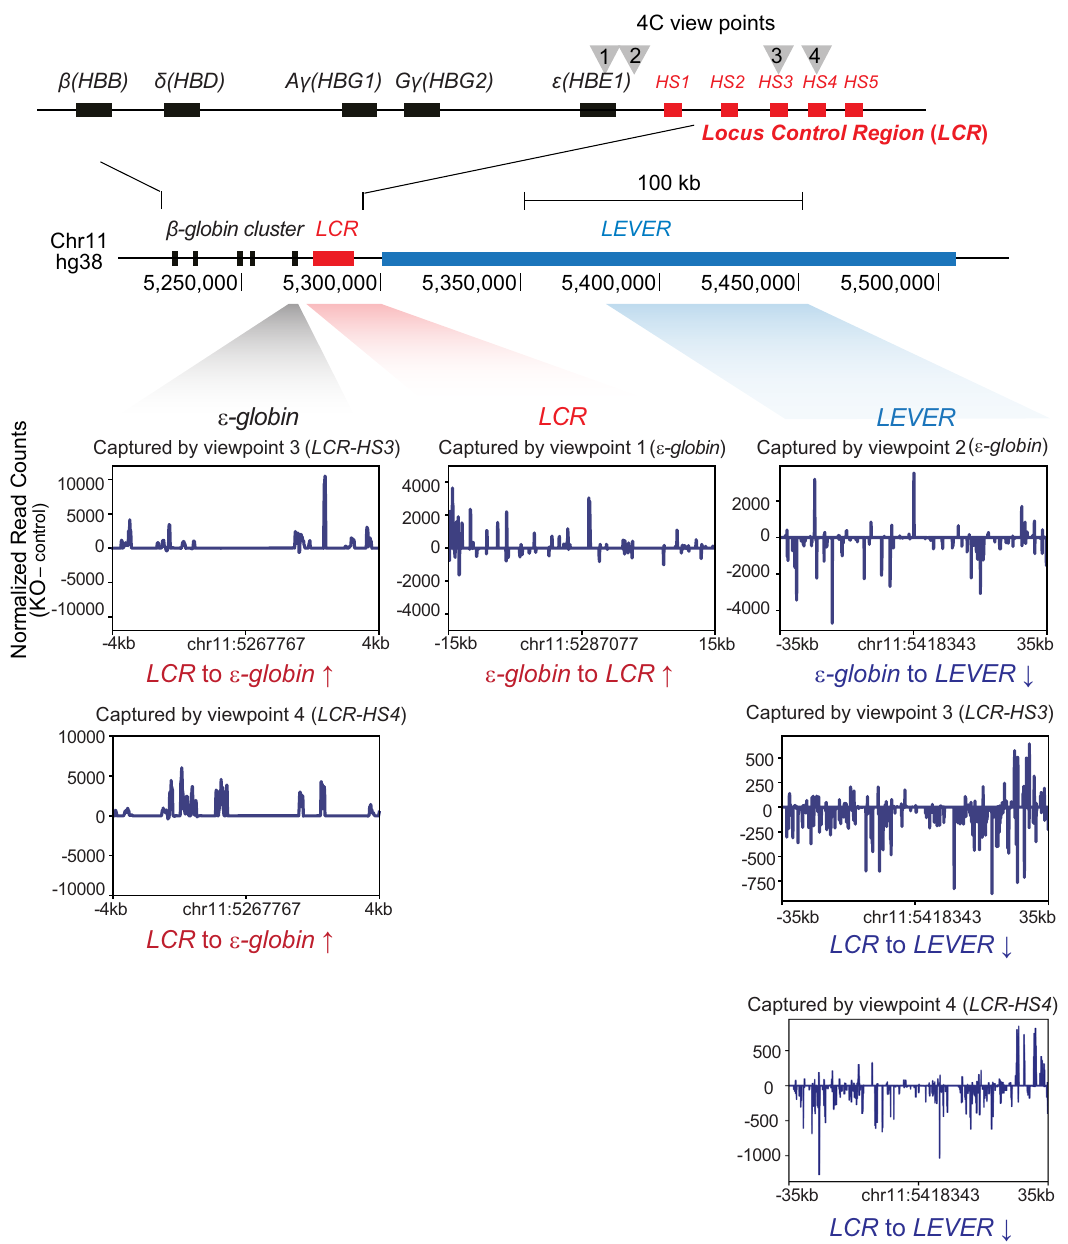
Fig. 5 The LEVER locus regulates ε -globin through long-range chromatin interactions. 4C analysis comparing local chromatin interactions near the β - globin cluster in LEVER KO and NTC cells shows increased ε -globin -LCR interaction upon LEVER knock-out. We positioned two viewpoints at the ε -globin promoter (viewpoint 1 and 2) and two viewpoints at HS3 (viewpoint 3) and HS4 (viewpoint 4) regions within the β -globin locus control region (LCR). Captured genomic fragments displayed in the windows correspond to the genomic regions shaded with gray ( ε -globin ), red (LCR), and blue ( LEVER ) colors below the chromosome map, with the central position of each region annotated below each window. Differentially interacted regions are shown in subtracted reads by comparing LEVER KO and NTC cells, thereby positive or negative values represent increased or decreased interactions upon LEVER KO,